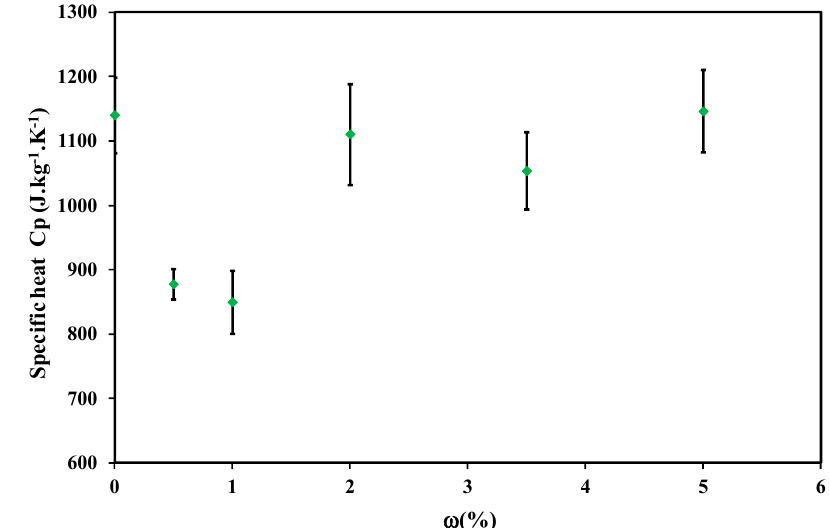
Figure 11. Specific heat variation with alfa fiber mass content. Measurements uncertainty is below 7%.